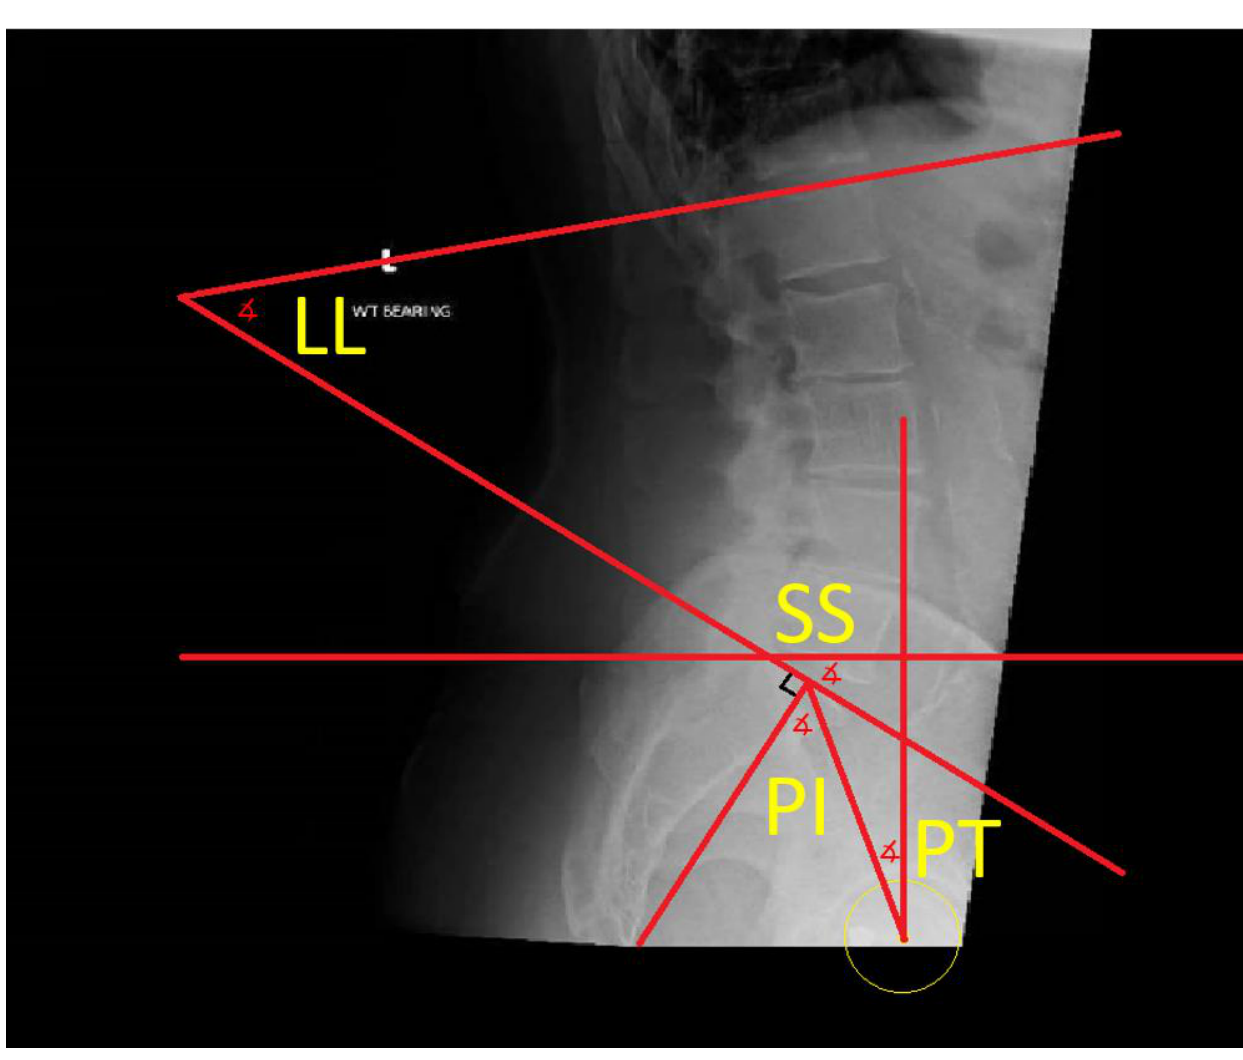
Figure 2. Annotated standing lateral lumbar spine xray defining the different spinopelvic parameters. Lumbar Lordosis (LL): the angle between superior end plates of L1 and S1; Sacral Slope (SS): the angle between a horizontal line and superior end plate of S1; Pelvic Tilt (PT): the angle between a vertical line and a line from femoral head (yellow circle) to midpoint of sacral endplate; Pelvic Incidence (PI): the angle between a line from the femoral head centre to midpoint of sacral endplate and a line perpendicular to the sacral end plate at its midpoint.